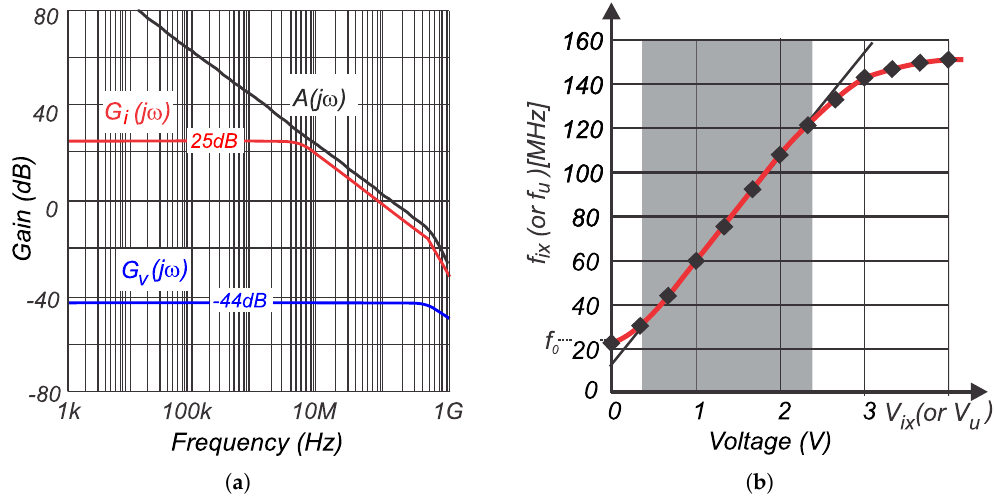
Figure 7. ( a ) Frequency characteristic of open-loop gain for LMH6611 (black line), inductor current measurement circuit (red line) and voltage measurement chain (blue line); ( b ) Measured VCO static